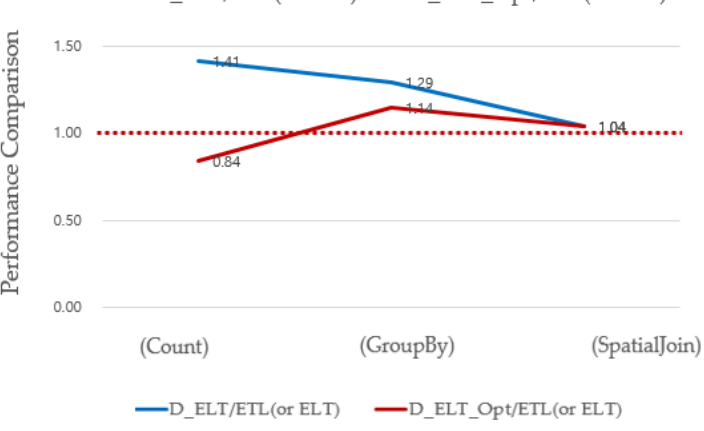
Figure 11. Performance comparison of D_ELT / ETL(or ELT) vs. optimized D_ELT / ETL(or ELT) based on the small data size for each of three analyses: Count, Group-By, and SpatialJoin.